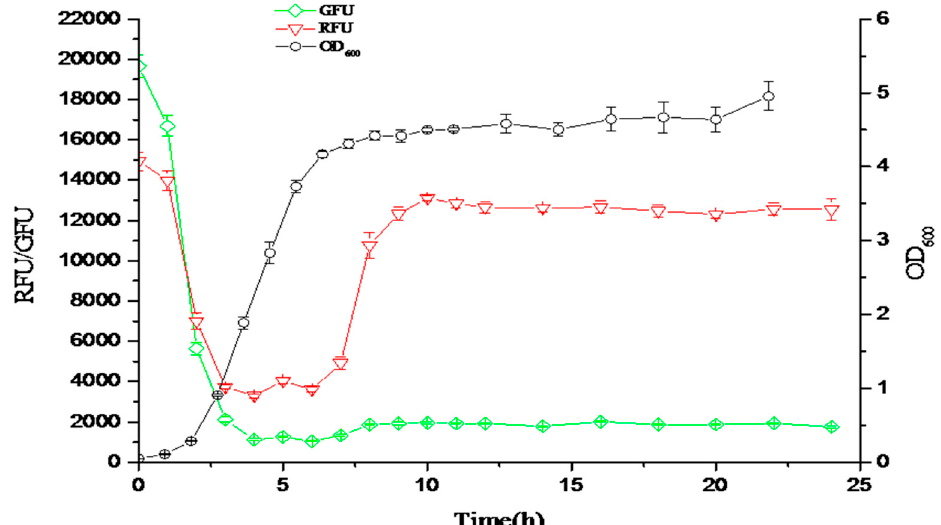
Figure 9. The responsive curves of the fluorescent ratio (OD 535 /OD 600 ) in response to the density of bacteria. The green curve is the green fluorescent ratio (OD 535 /OD 600 ) responding to the low density of bacteria. The red curve is the red fluorescent ratio (OD 535 /OD 600 ) responding to the high density of bacteria. The black curve is the cell density of bacteria (OD 600 ).